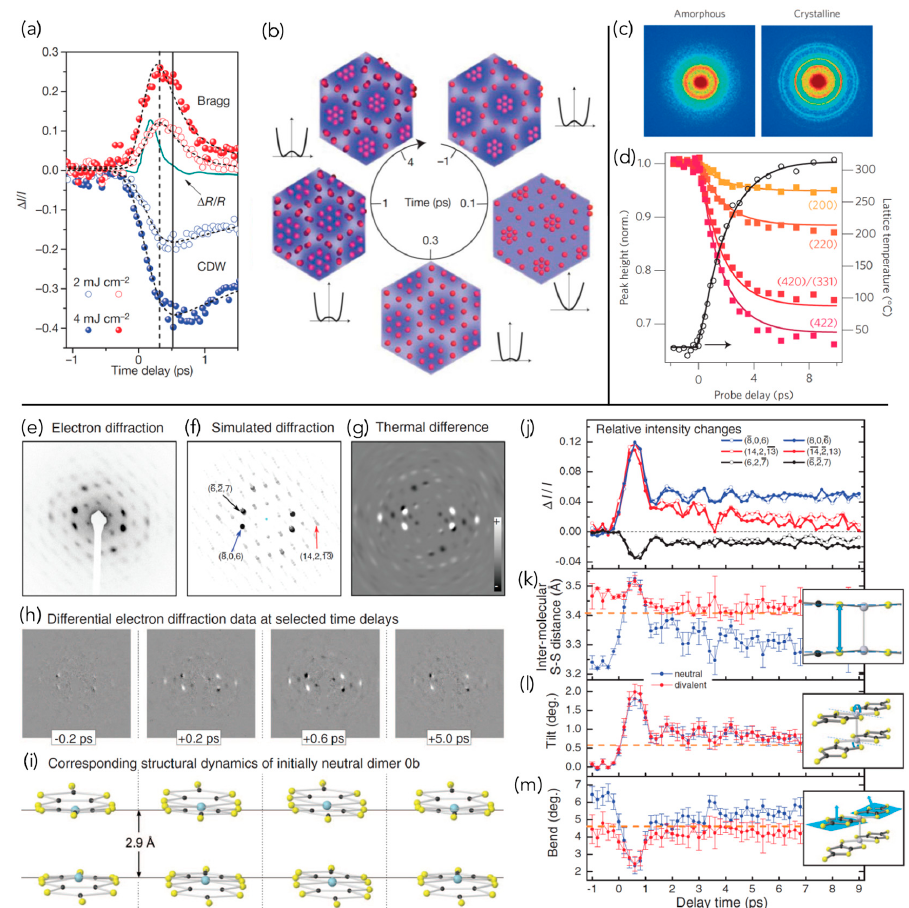
Figure 15. Compact FED setups, measurements in transmission geometry. ( a – b ) Time evolution of the CDW state in 1T-TaS 2 upon photoexcitation. ( a ) The circles correspond to FED and the solid traces to transient reflectivity data, respectively. A detailed analysis of the evolution of Bragg and CDW peaks, and optical measurements provides an atomically resolved movie highlighting the interplay between electronic and nuclear degrees of freedom. ( b ) Intense perturbation of the electronic system gives rise to smearing of the electron density modulation ( t < 0.1 ps), driving the lattice towards the undistorted state ( t < 0.3 ps). At the same time, the energy is transferred from the electronic subsystem to phonons, resulting in the recovery of the electron density modulation and thermal disordering of the lattice ( t < 1 ps). The CDW order is nearly recovered at t < 4ps, after which time the sample is thermalized at a somewhat higher temperature. Figure adapted from Reference [183] with permission from Springer Nature. ( c – d ) Transient optical properties and structural transitions in phase-change material Ge 2 Sb 2 Te 5 (GST). ( c ) Diffraction patterns of crystalline and amorphous states recorded with 92-keV fs-electron pulses. ( d ) Below-threshold dynamics in crystalline GST showing the time evolution of diffraction peaks and the extracted temperature rise. Figure adapted from Reference [190] with permission from Springer Nature. ( e – m ) Collective modes coupled to charge transfer in Me 4 P[Pt(dmit) 2 ] 2 . ( e ) Experimental diffraction pattern of Me 4 P[Pt(dmit) 2 ] 2 at 90 K. ( f ) Simulated diffraction showing the contributions of individual reflections and selected peaks. ( g ) Simulated difference pattern for the thermal phase transition: charge-separated phase → high-temperature (metallic) phase. ( h ) Differential FED data [I on (t) − I off ] at different t following photoexcitation. ( i ) Snapshots of the structural dynamics constructed from the FED data. ( j ) Temporal profiles of the relative intensity changes of selected diffraction peaks. ( k – m ) Dynamics of key structural modes involved in the photoinduced phase transition of dimers initially neutral (blue) and divalent (red), compared with the thermal phase transition (dashed orange lines). Figure adapted from Reference [223] with permission from Science